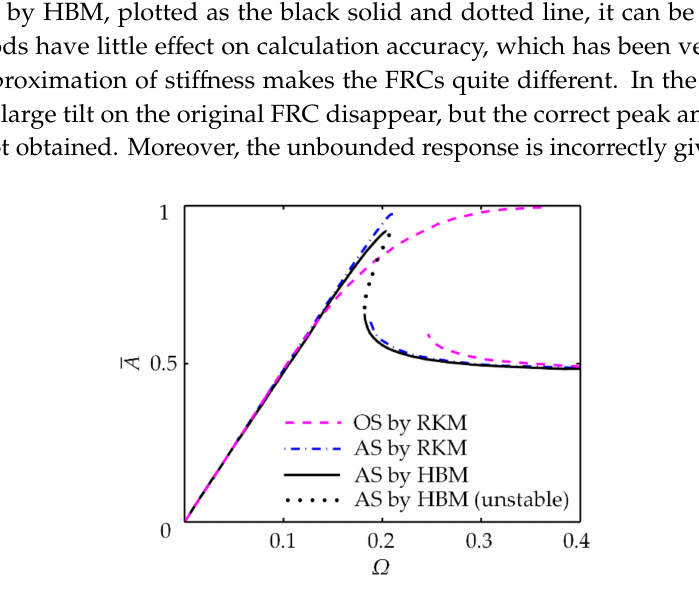
Figure 10. Comparisons between FRCs about original and approximate sti ff ness computed by Runge–Kutta method (RKM) and the harmonic balance method